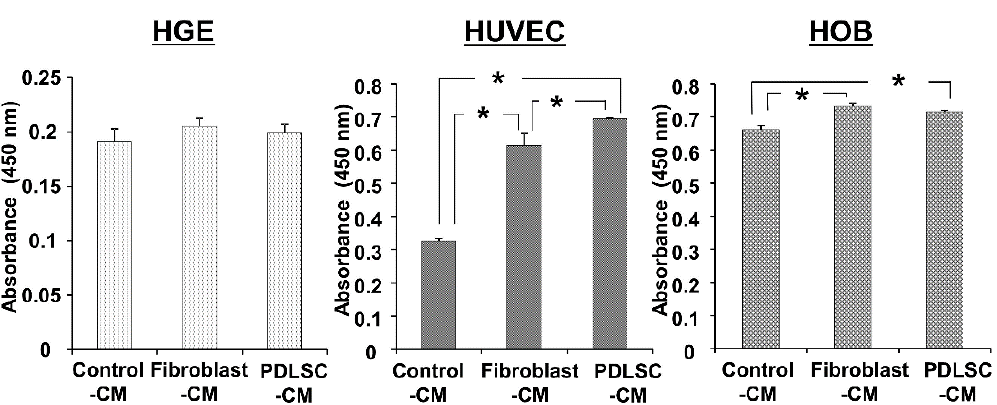
Figure 2. Effect of CM on the cell viability of HGEs, HUVECs, and HOBs. HGEs, HUVECs, and HOBs were incubated in Control-CM, Fibroblast-CM, and PDLSC-CM for 48 h, and cell viability was examined using water soluble tetrazolium salt (WST)-8. Cell viability is shown as the absorbance value at 450 nm. PDLSC-CM and Fibroblast-CM increased cell viability of HUVEC and HOB. HUVEC exhibited higher viability when cultured in PDLSC-CM compared to in Fibroblast-CM. (* p < 0.05, HGE = human gingival epithelial cells, HUVECs = human umbilical cord vein endothelial cells, HOB = human osteoblasts, CM = conditioned medium, PDLSCs = periodontal ligament stem cells). All experiments were performed in triplicates, and the representative data from an independent experiment performed three times were shown. ( n = 3).